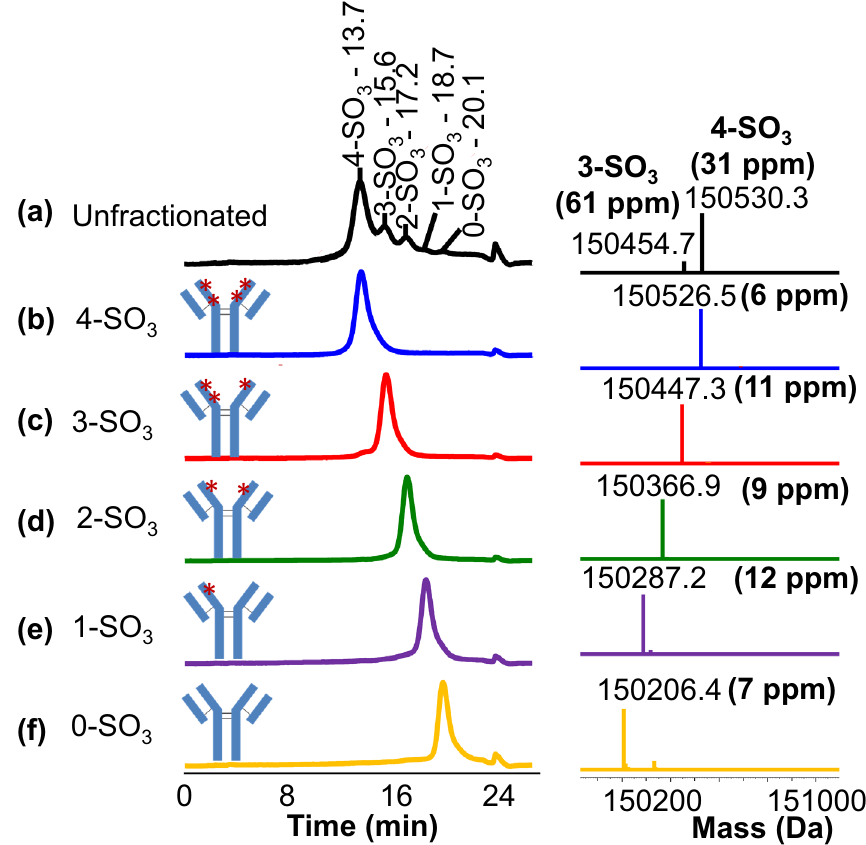
Figure 1. HIC-UV chromatograms and RPLC-mass spectrometry analysis distinguishing CAP256V2LS sulfation proteoforms. Traces on the left are CAP256V2LS analyzed by HIC-UV. (y-axis is the UV absorbance, normalized to the highest peak intensity in each chromatogram). On the right, deconvoluted Reversed phase coupled with intact mass analysis from each peak fraction corresponding to the left elution after deglycosylation. (y-axis is the mass intensity, normalized to the highest peak in each mass spectrum.) ( a ) Unfractionated CAP256V2LS showed five peaks on HIC-UV chromatograms, with the peak of 4-SO 3 and 3-SO 3 species detected in RPLC-MS. ( b ) 4-SO 3 eluted first at 13.7 min with mass confirmed at 150,526.5 Da. ( c ) 3-SO 3 eluted at 15.6 min with mass of 150,447.3 Da. ( d ) 2-SO 3 eluted at 17.2 min with mass observed at 150,366.9 Da. ( e ) 1-SO 3 eluted at 18.7 min with mass detected at 150,287.2 Da. ( f ) 0-SO 3 eluted last at 20.1 min with mass measured at 150,206.4